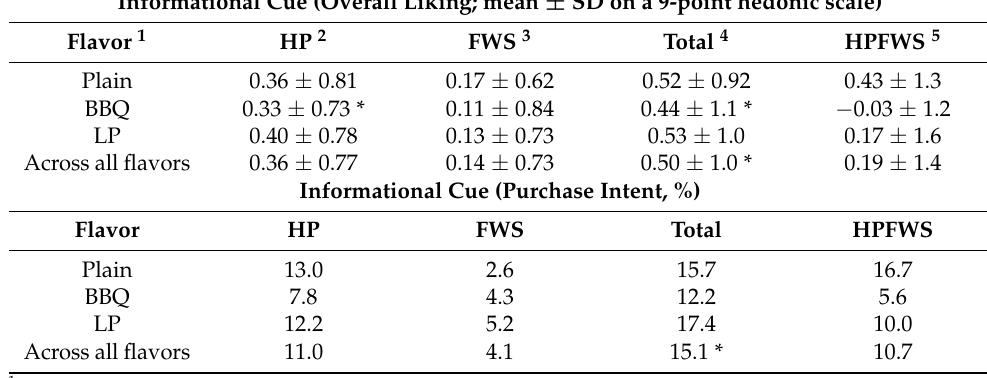
Table 4. Comparing effects of informational cue format on overall liking and purchase intent (%) of catfish skin chips after each given informational